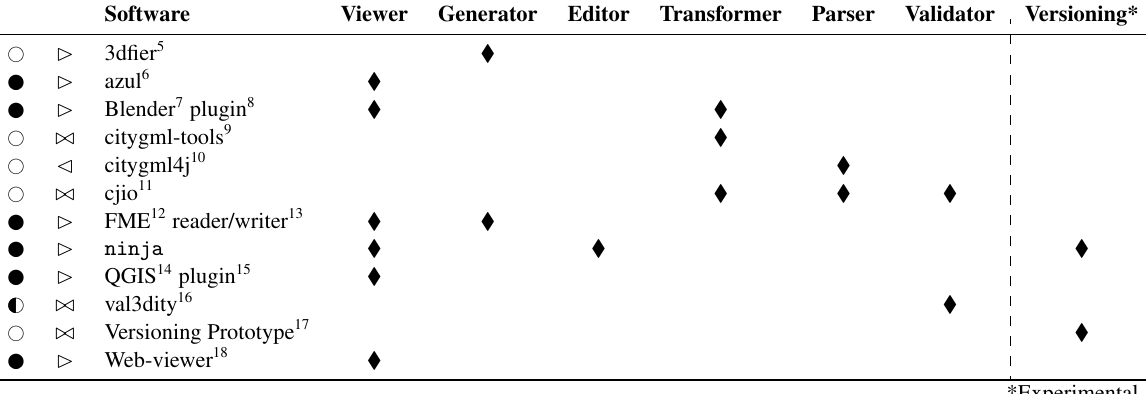
Table 1. Software Support for